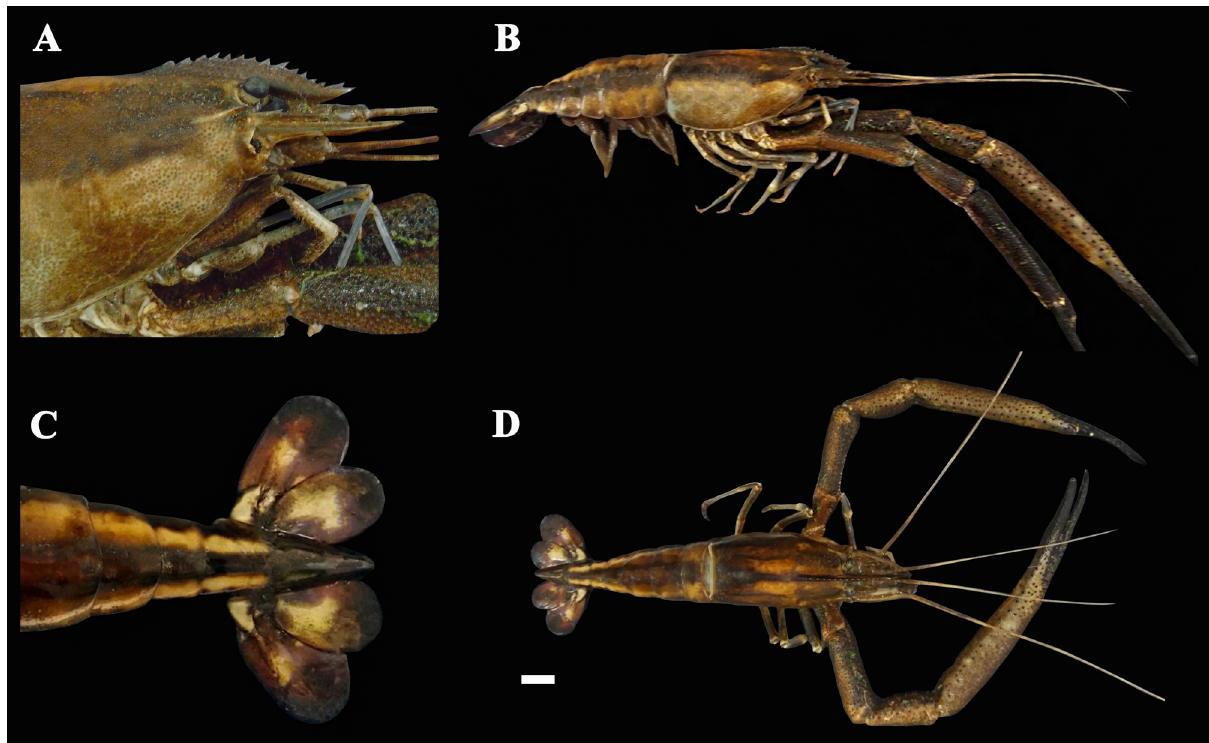
Figure 4. Macrobrachium carcinus (Linnaeus, 1758), male [CZDP (F2) 0061]. A, Detail of the anterior region of the carapace; B, habitus, lateral view; C, detail of the telson and uropods, dorsal view; D, habitus, dorsal view. Scale bar: 2